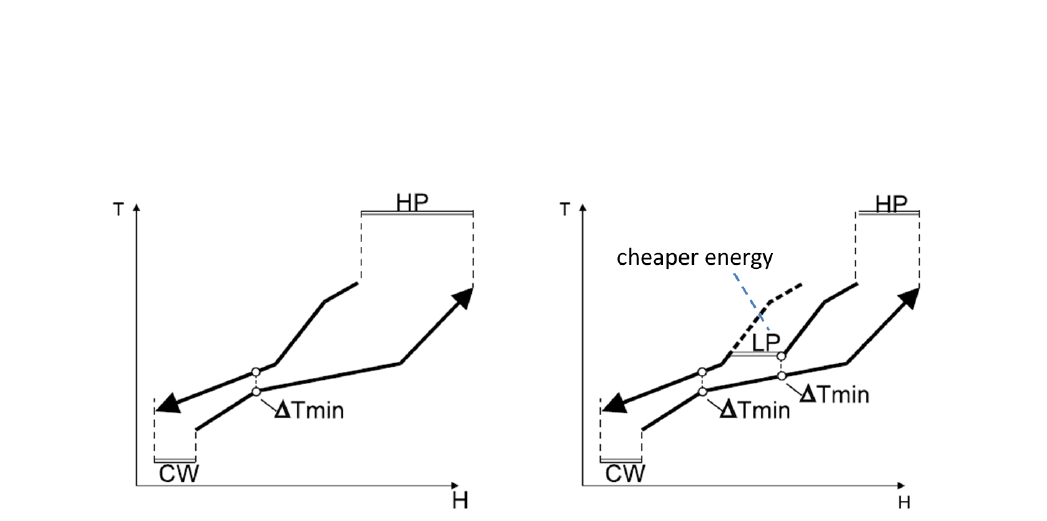
Fig. 32. – Saving expensive sources by moving to cheaper sources. CW can be cooling water or chilled water, depending on the temperature [10].